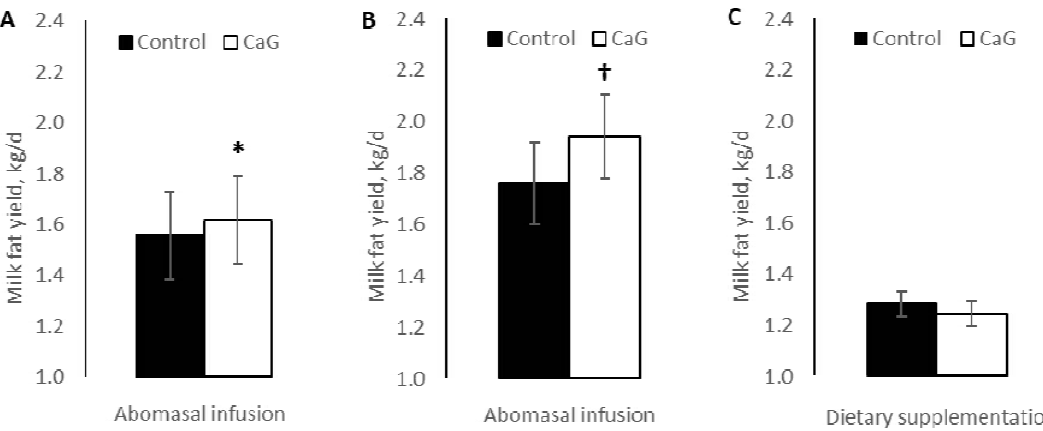
Figure 2. Milk fat yield response to ( A ) an abomasal infusion of 5–46 g / day [133], ( B ) an abomasal infusion of 44–187 g / day [134], and ( C ) dietary supplementation of 45 g / d [133] of unprotected calcium gluconate (CaG). Within experiments, no differences were detected between infused CaG doses, and the results of the control vs. CaG contrast are shown. * p < 0.05; † p < 0.10.